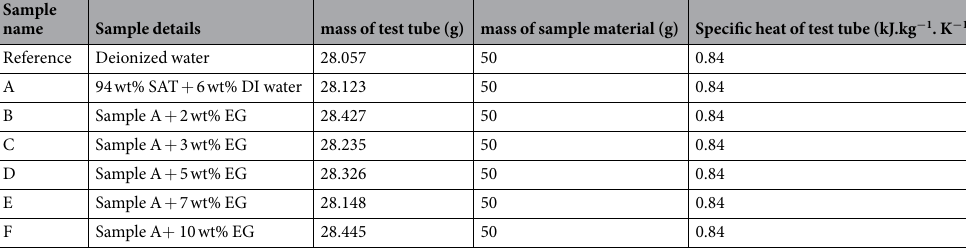
Table 1. Physical properties of test tubes, PCMs and DI water used for